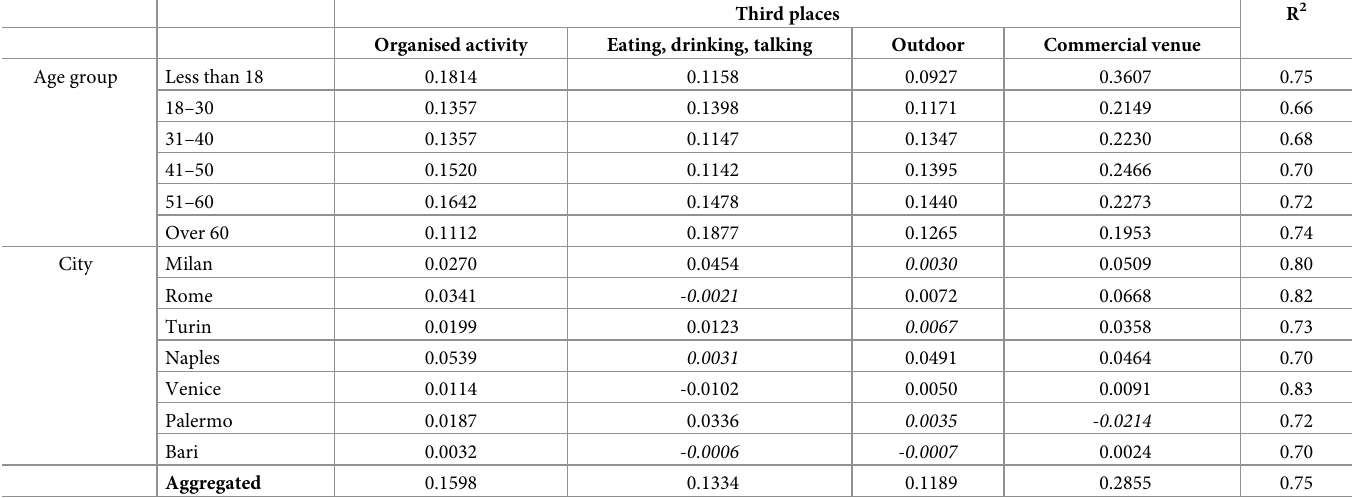
Table 4. Investigating the role of third places on urban vibrancy. Further to the analysis above, we investigate in more detail the relationship between each third places category and urban vibrancy. As before, we construct a range of multivariate spatial models and present the results in this table. The table shows the values of the model coefficients, and values are reported in italic and small font size if they are not significant after fdr correction ( p > 0.05). The last column reports the Nagelkerke pseudo R square value.